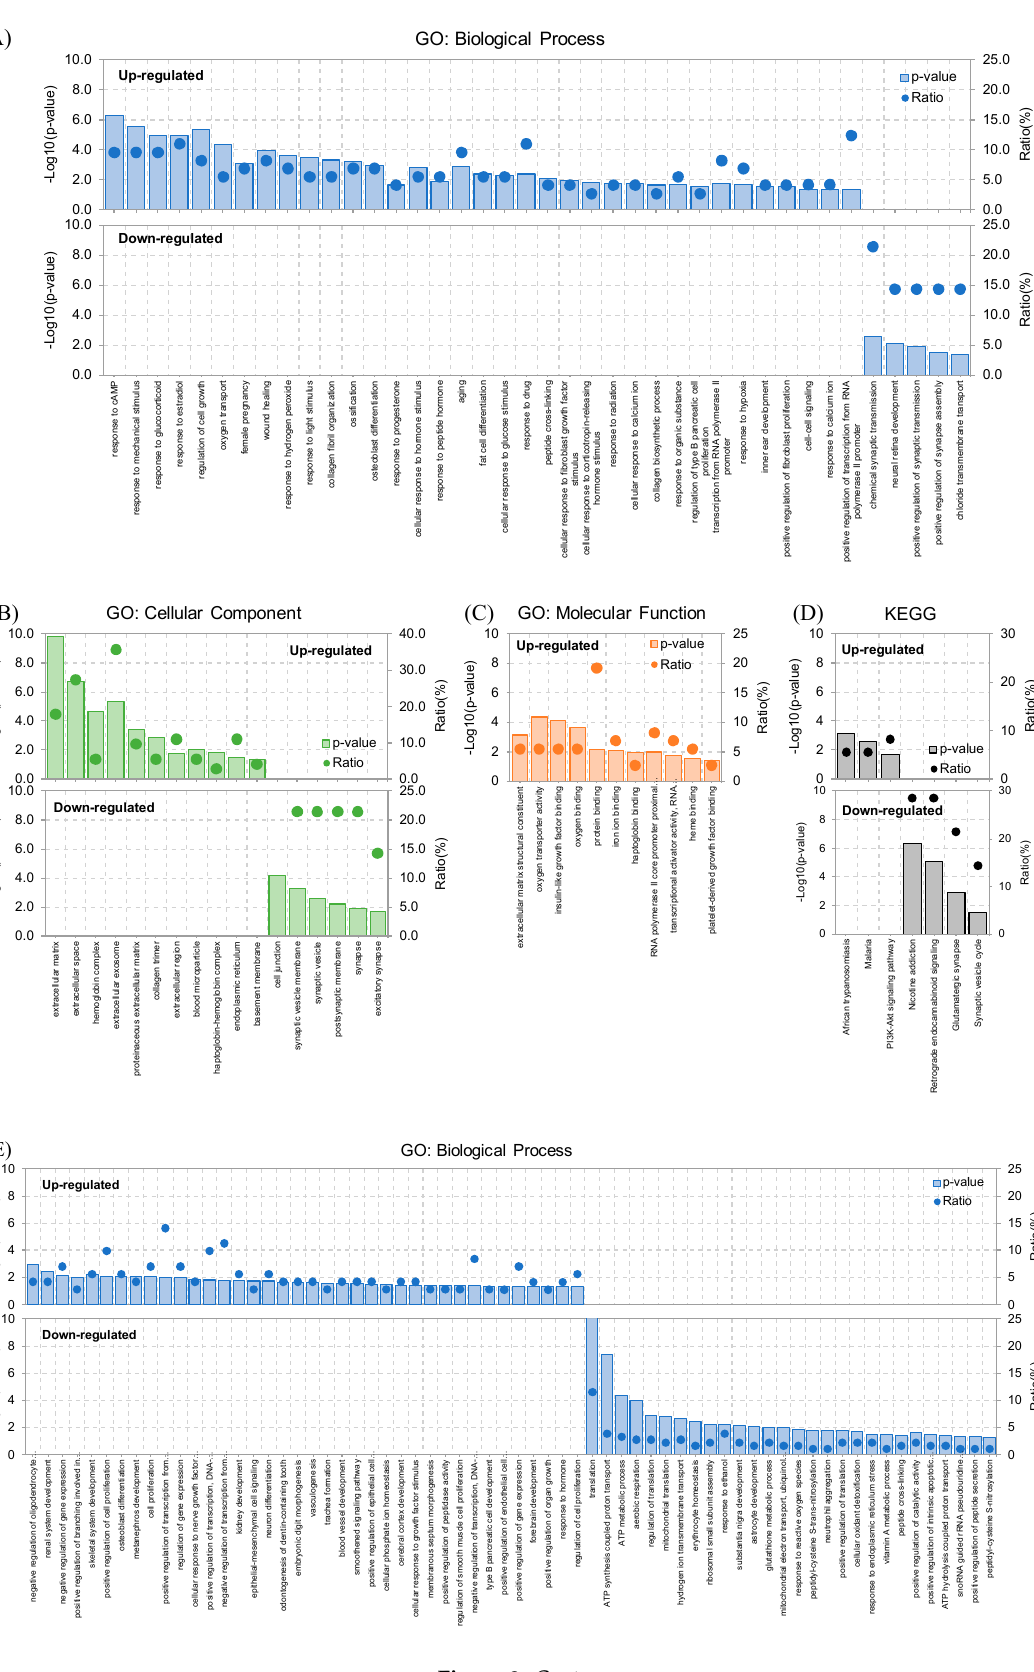
negative correlations of the genes are indicated by the red and blue color, respectively.